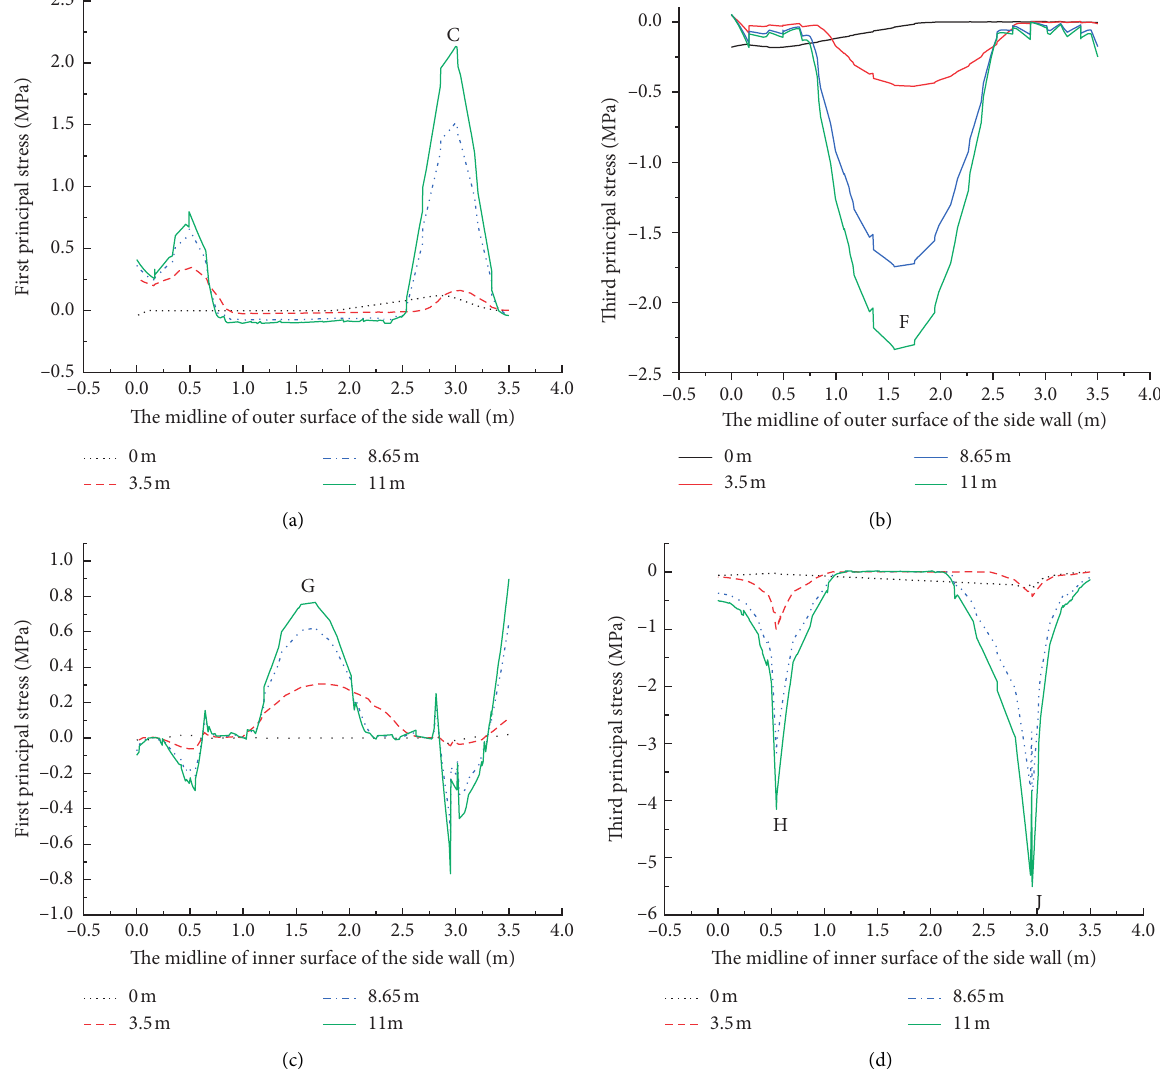
Figure 9: Main stress variation curve of concrete on the midline of the side wall. (a) First principal stress on the outer surface. (b) Third principal stress on the outer surface. (c) First principal stress on the inner surface. (d) Third principal stress on the inner